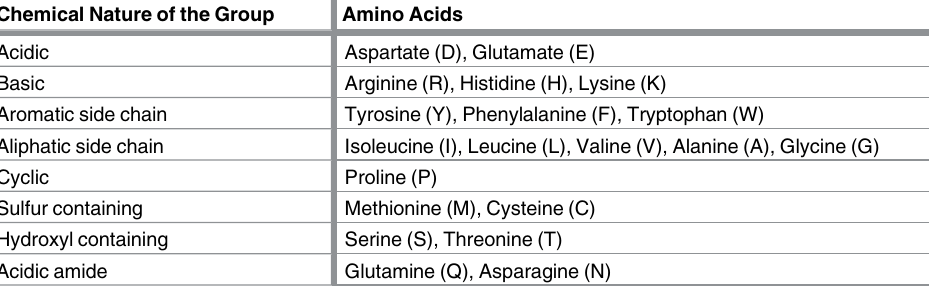
Table 1. Amino acid categorization based on their chemical nature.